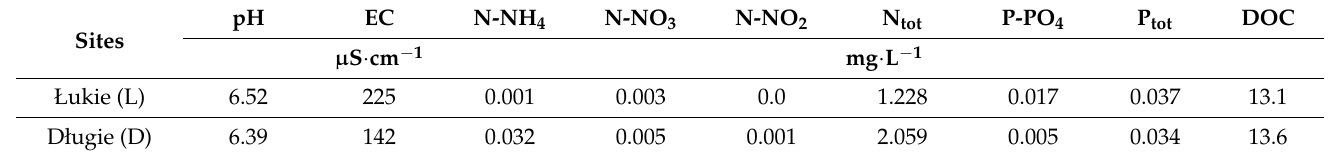
Table 1. Characteristics of physical–chemical conditions of water from the studied